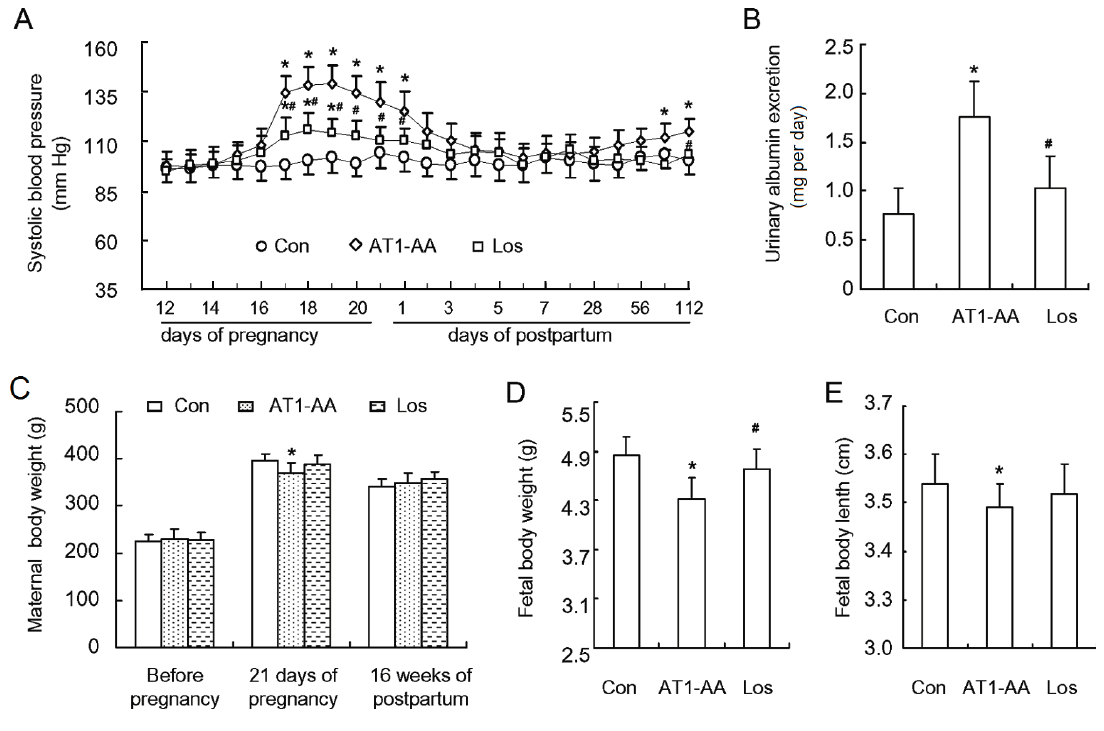
Figure 1. Affinity-purified AT1-AA (angiotensin II receptor type 1 autoantibody) induced an increase in SBP (systolic blood pressure) and proteinuria in pregnant rats. ( A ) SBP in pregnant rats after AT1-AA injection (1:640) at gestation day 13 in the presence or absence of losartan; ( B ) the ratio of urinary albumin/creatinine at gestation day 19; ( C ) maternal rat body weight (prior to, during and after pregnancy); ( D ) fetal rat body weight; and ( E ) fetal rat body length. Data represent the mean result from AT1-AA-injected rats, showing a significant increase in SBP and urinary protein. Con: control group; AT1-AA: AT1-AA group; Los: AT1-AA + losartan group. Data are expressed as means ± SD. ( A – C ): n = 6; ( D , E ): n = 32. * p < 0.05 vs. control group. # p < 0.05 vs. AT1-AA